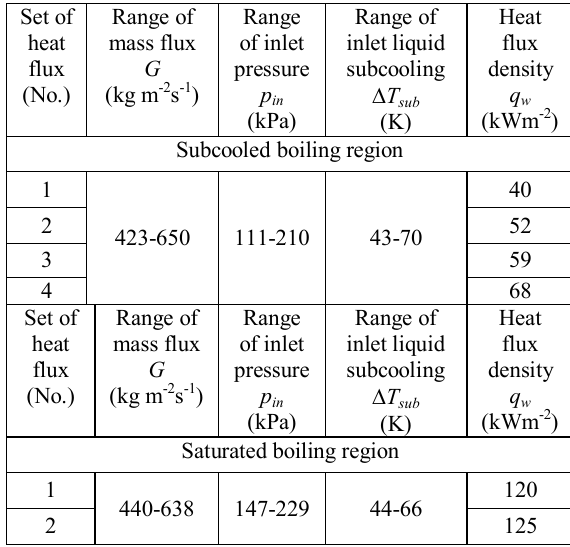
Table 1 Experimental parameters of experimental series for the subcooled and saturated boiling regions.